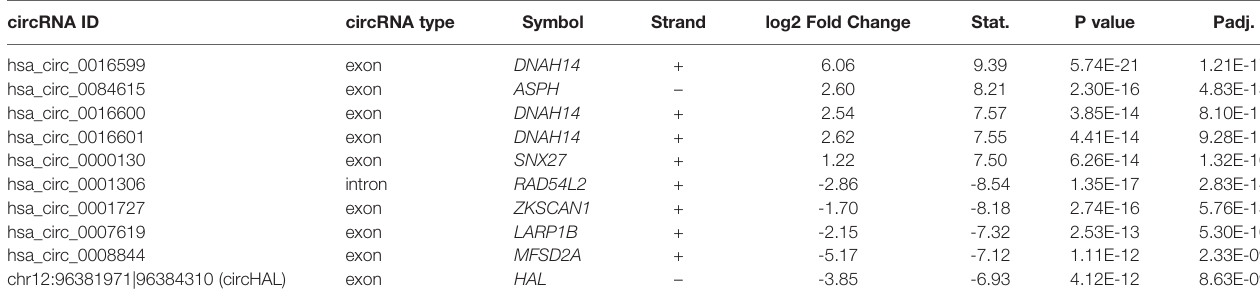
TABLE 1 | The top- fi ve upregulated and downregulated circRNAs in HCC. circRNA ID circRNA type Symbol Strand log2 Fold Change Stat. P value